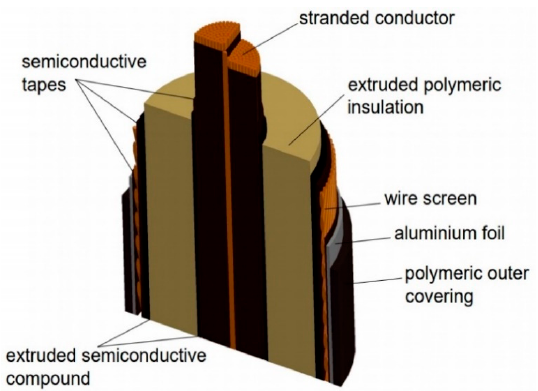
Figure 2. Typical high voltage direct current (HVDC) large size cable.